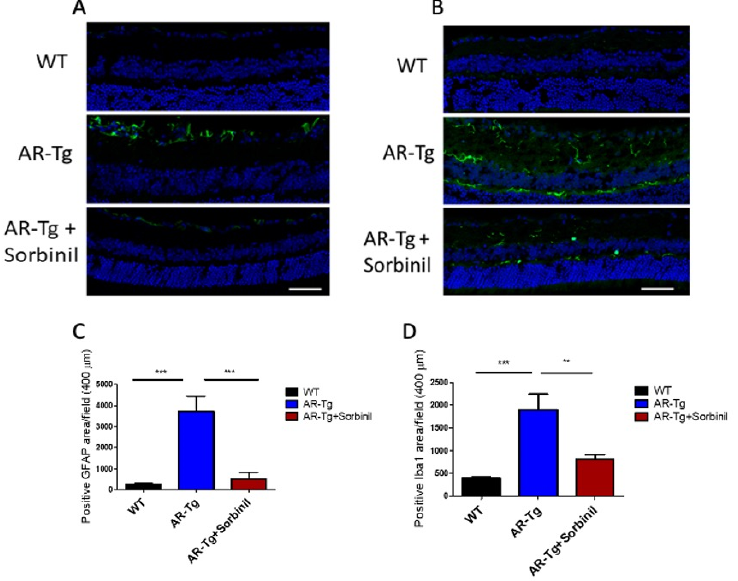
Figure 6. Retinas from AR-Tg animals showed an increase in expression of inflammatory markers that was reduced with Sorbinil treatment. ( A ) Analysis of immunofluorescence images showed a significantly increased number of activated glia (GFAP signal, green) in the inner nuclear layer of AR-Tg mice compared to age-matched controls. The area of GFAP signal in AR-Tg mice treated with Sorbinil was significantly reduced. ( B ) Analysis of immunofluorescence images demonstrated a significantly larger number of retinal microglia (Iba-1 signal, green) throughout the inner and outer nuclear layers of AR-Tg mice compared to age-matched WT controls. The area of Iba-1 signal in AR-Tg mice treated with Sorbinil was significantly reduced compared to untreated AR-Tg mice, but did not return to the level seen in WT animals. ( C , D ) GFAP and Iba-1 expression levels were quantified by pixel counts in microscopic fields in retinal sections from designated animal strains, respectively. Tissues were counter-stained with DAPI (blue). Mice were 24 weeks of age. Scale bar equals 50 μ m. ** p < 0.01, *** p < 0.001.